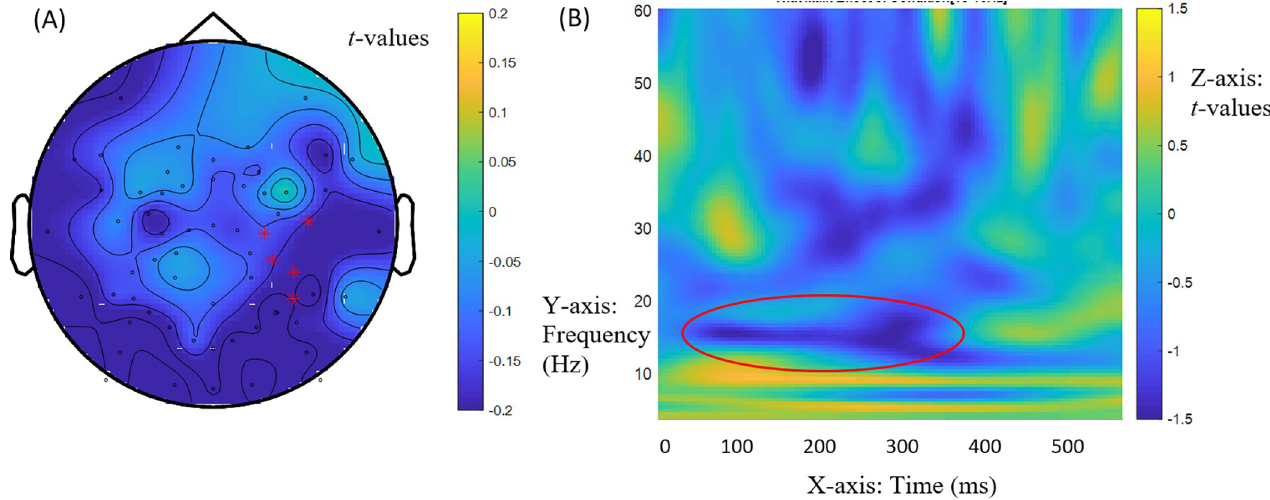
Fig 3. General effects at subordinator que ‘that’ at 15-16Hz (low beta band). (A) Mod-Comp differences across match and mismatch conditions [(2a)— (2b)]—[(2c)—(2d)] in induced power at subordinator que ‘that’ at 15-16Hz (low beta range) between 32 and 367ms across NS and NNS groups. The red marks indicate the electrodes for these effects (electrodes ‘E46’, ‘E49’, ‘E50’, ‘E53’, ‘E56’). (B) Time (x axis) frequency (y axis) plot of Mod-Comp differences in induced power (z axis). The circled area shows the effects.